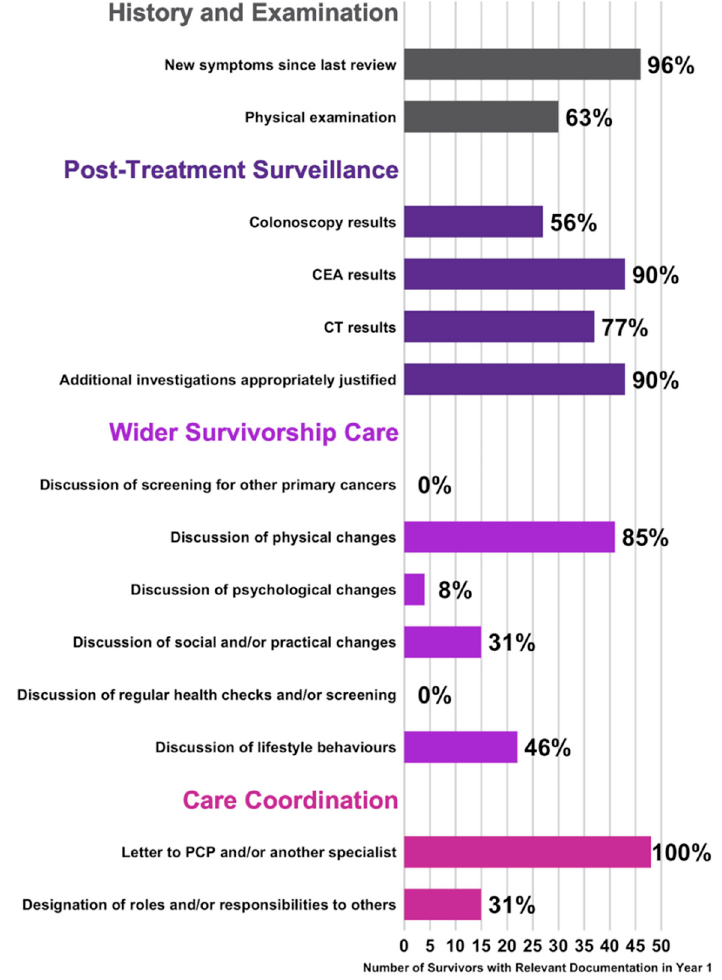
Figure 4. Documented content of follow-up visits in the study population ( n = 48) in the first year of follow-up (360 days). The x-axis denotes the number of survivors that had at least one visit in their first year containing appropriate documentation relevant to the specific element of survivorship care according to the ACS survivorship care guidelines [8]. These are broadly represented by four key aspects of history and examination (grey), post-treatment surveillance (dark purple), wider survivorship care (magenta), and care coordination (pink). Percentages are denoted at the end of the bar graphs. ACS: American Cancer Society; CEA: carcinoembryonic antigen; CT: computed tomography; PCP: primary care physician.